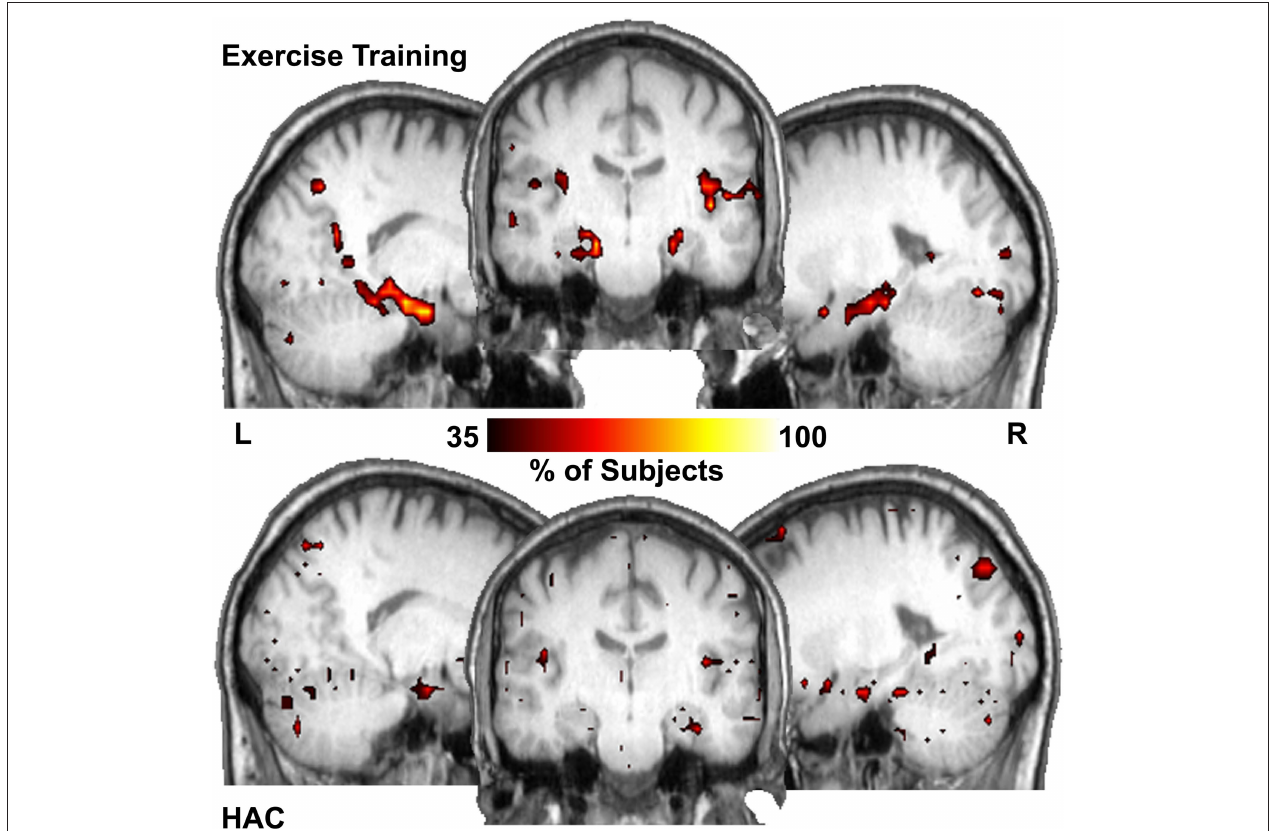
HAC group a small portion of the right hippocampus is a common hub but much less so than the ET group. Color bar shows the percentage of subjects with a hub in each